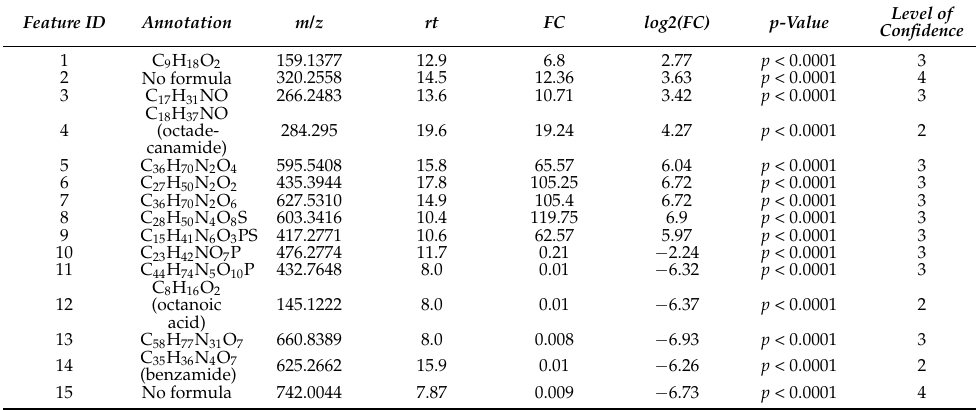
Table 5. The most significant metabolomic features annotated for the fat body samples from Manduca sexta larvae fed for three weeks on leaves of tomato plants that were non-inoculated and root- inoculated with Trichoderma harzianum . The feature number corresponds to the features given in Figure 6B, which are given by their corresponding mass to charge ratio ( m / z ) and retention time (rt) in minutes. The fold change (FC) refers to the feature’s qToF intensity and was calculated on the basis of a volcano plot conducted for the non-inoculated and T. harzianum -inoculated larvae. The volcano plot was conducted with a fold change threshold ( x -axis) of 2 and t -test threshold ( y -axis) of 0.05. The level of confidence of the identification/annotation is given according to Malinowska and Viant [45]. Feature ID